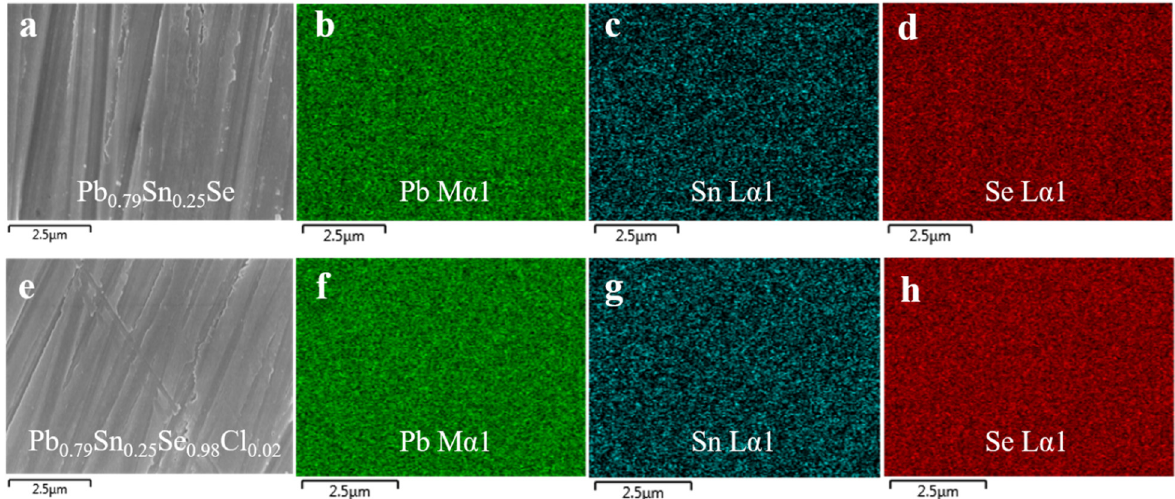
Figure 2. ( a ) Scanning electron microscope (SEM) image of the sintered Pb 0.79 Sn 0.25 Se and elemental maps of ( b ) Pb, ( c ) Sn, and ( d ) Se. ( e ) SEM image of the sintered Pb 0.79 Sn 0.25 Se 0.98 Cl 0.02 and elemental maps of ( f ) Pb, ( g ) Sn, and ( h ) Se.